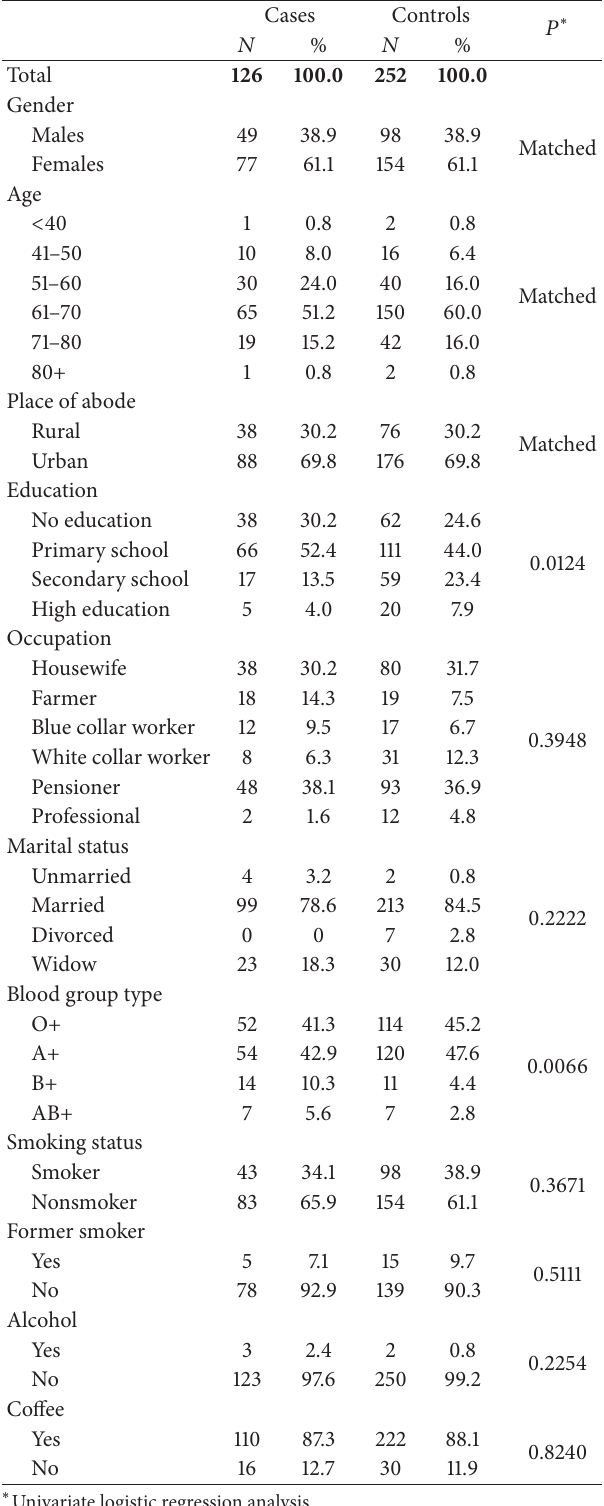
Table 1: Sociodemographic characteristics, blood group type, and habits of